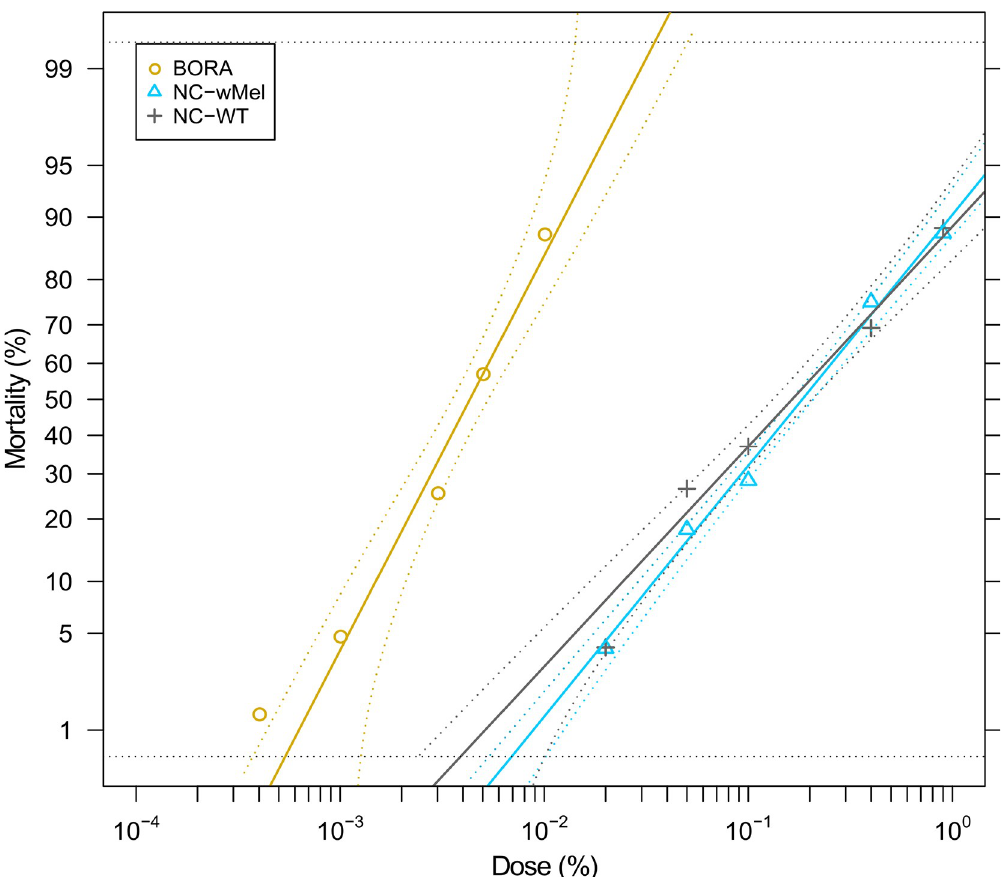
Fig 4. Dose-mortality to deltamethrin for NC- w Mel, NC-WT, and Bora strains. For each strain and each dose tested, 70 to 100 females (2–5 days old) were exposed for 1 h, and mortality was recorded at 24 h. The yellow dots (Bora), the blue triangles (NC- w Mel) and the gray crosses (NC-WT) represent mortalities recorded for each dose. Dotted lines indicate the Confidence Interval at 95%.